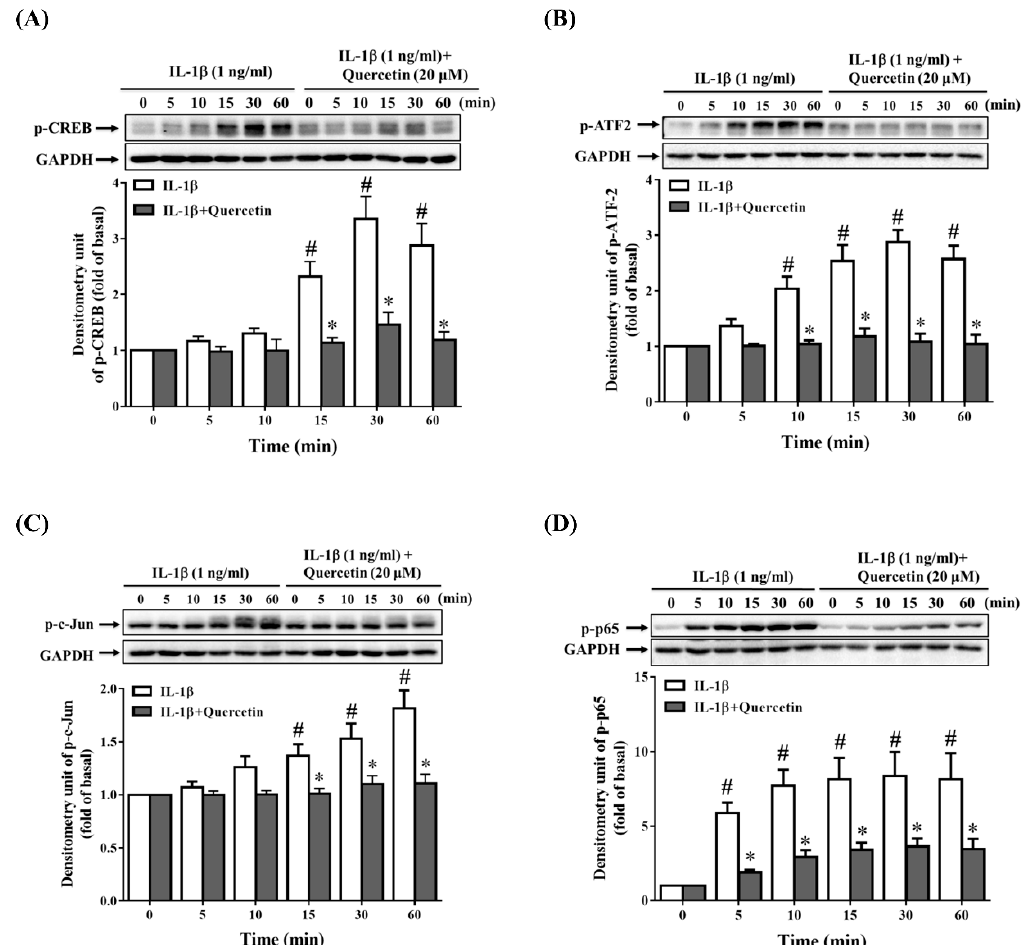
Figure 5. Quercetin attenuates the phosphorylation of cAMP response element-binding protein (CREB), activating transcription factor 2 (ATF2), c-Jun and nuclear factor (NF)- κ B p65 in IL-1 β -stimulated ARPE-19 cells. ARPE-19 cells were treated with 20 µ M quercetin for 1 h prior to stimulation with 1 ng / mL IL-1 β for the indicated time. Western blotting and Image Lab software were used to analyze and quantify the phosphorylation of ( A ) CREB, ( B ) ATF2, ( C ) c-Jun and ( D ) Nuclear factor (NF)- κ B p65. The data are expressed as mean ± SD of three independent experiments. # p < 0.05 versus control cells. * p < 0.05 versus IL-1 β -stimulated cells.